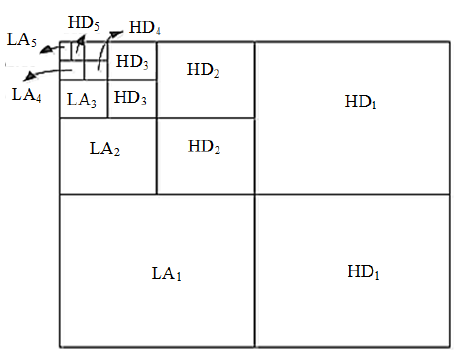
Fig. 2 Structure of five-layer wavelet